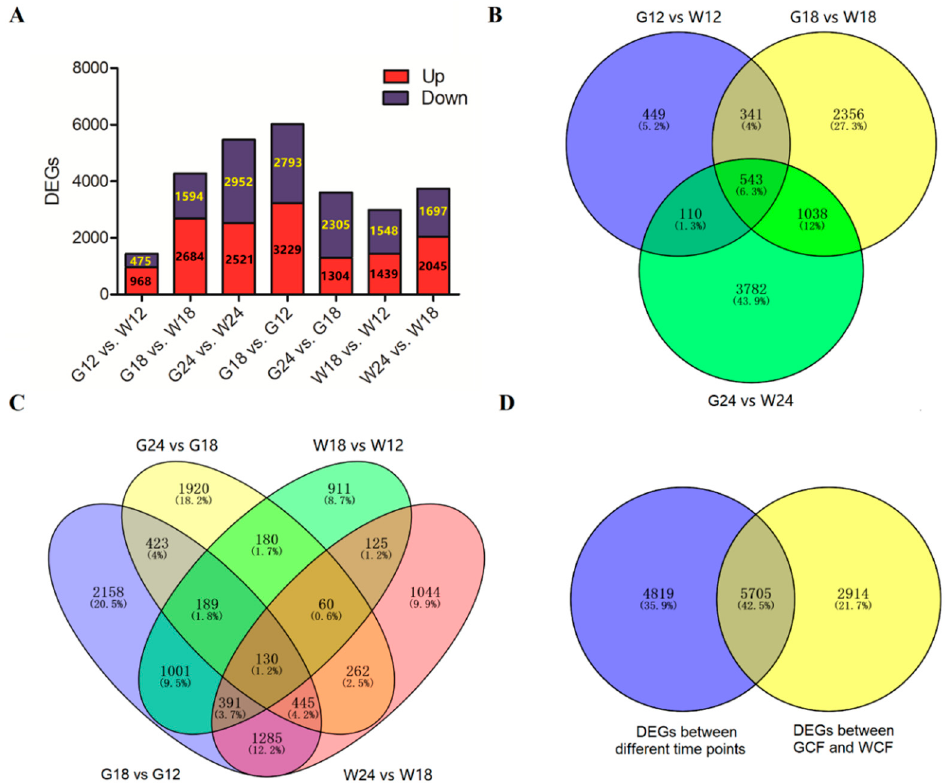
Figure 3. Differentially expressed genes (DEGs) between GCF and WCF. ( A ) The total number of DEGs identified in each comparison. ( B ) Venn diagram showing DEGs between GCF and WCF in the three time points. ( C ) Venn diagram showing DEGs between different time points in GCF or WCF. ( D ) The total number of non-redundant DEGs between different time points as well as between GCF and WCF.